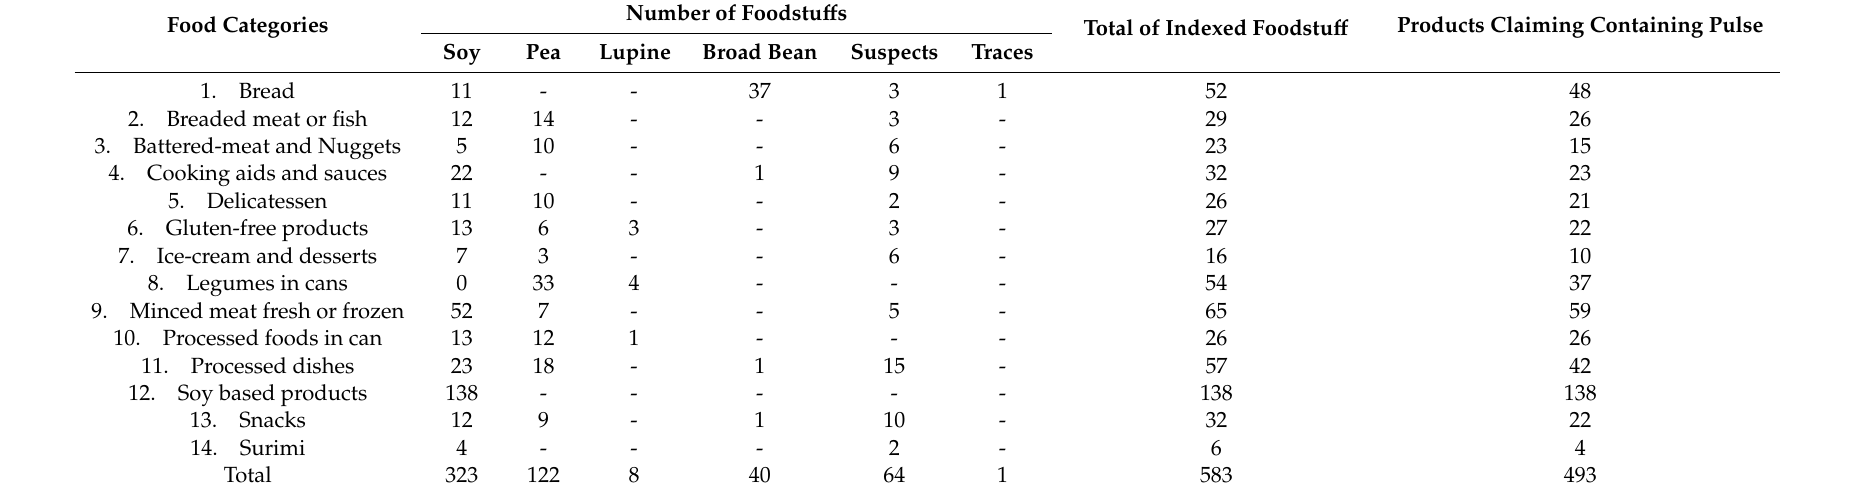
Table 1. Repartition of the pulses of interest in selected foodstu ff categories from